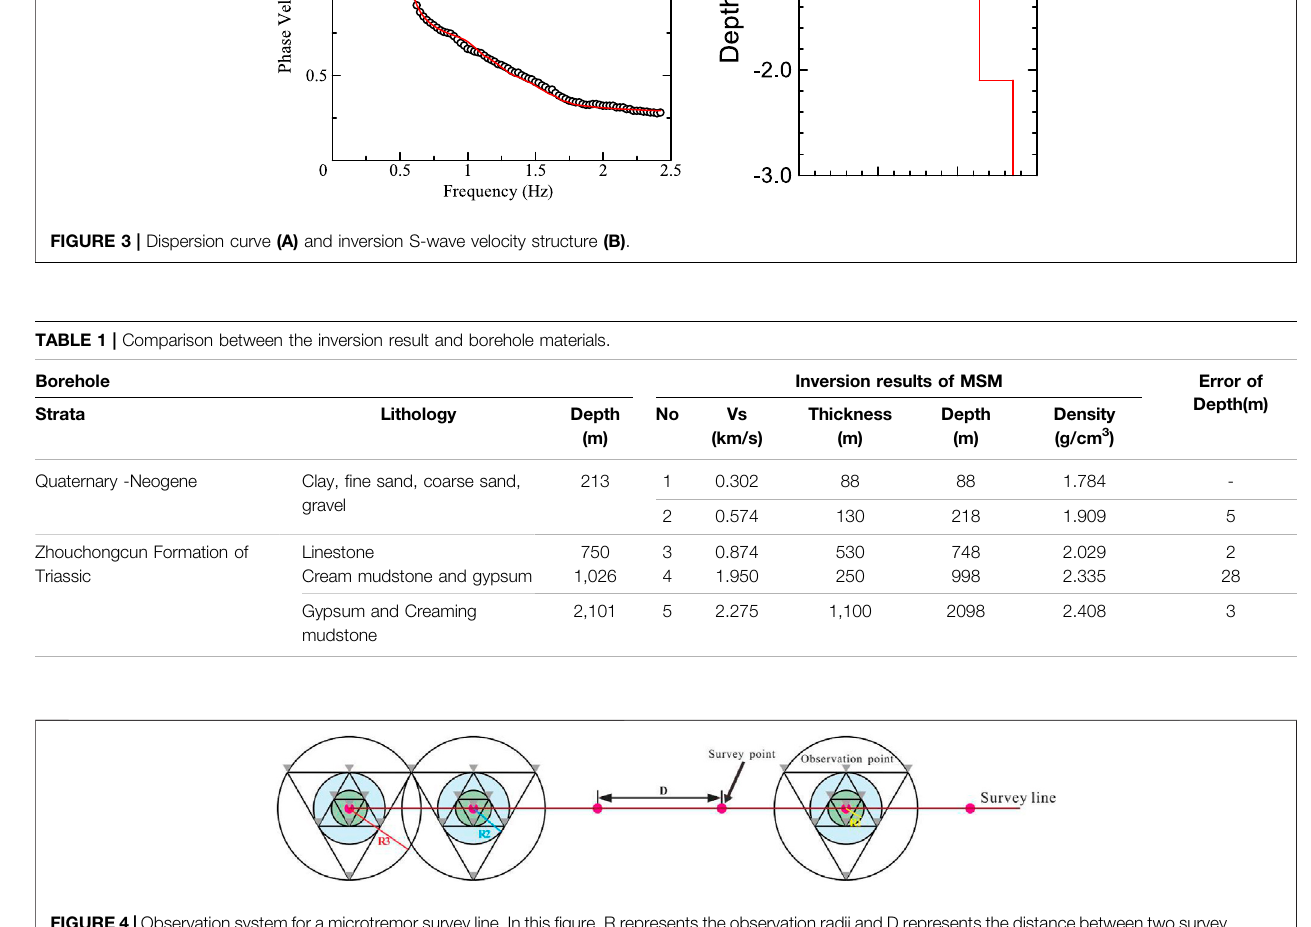
Frontiers in Earth Science |